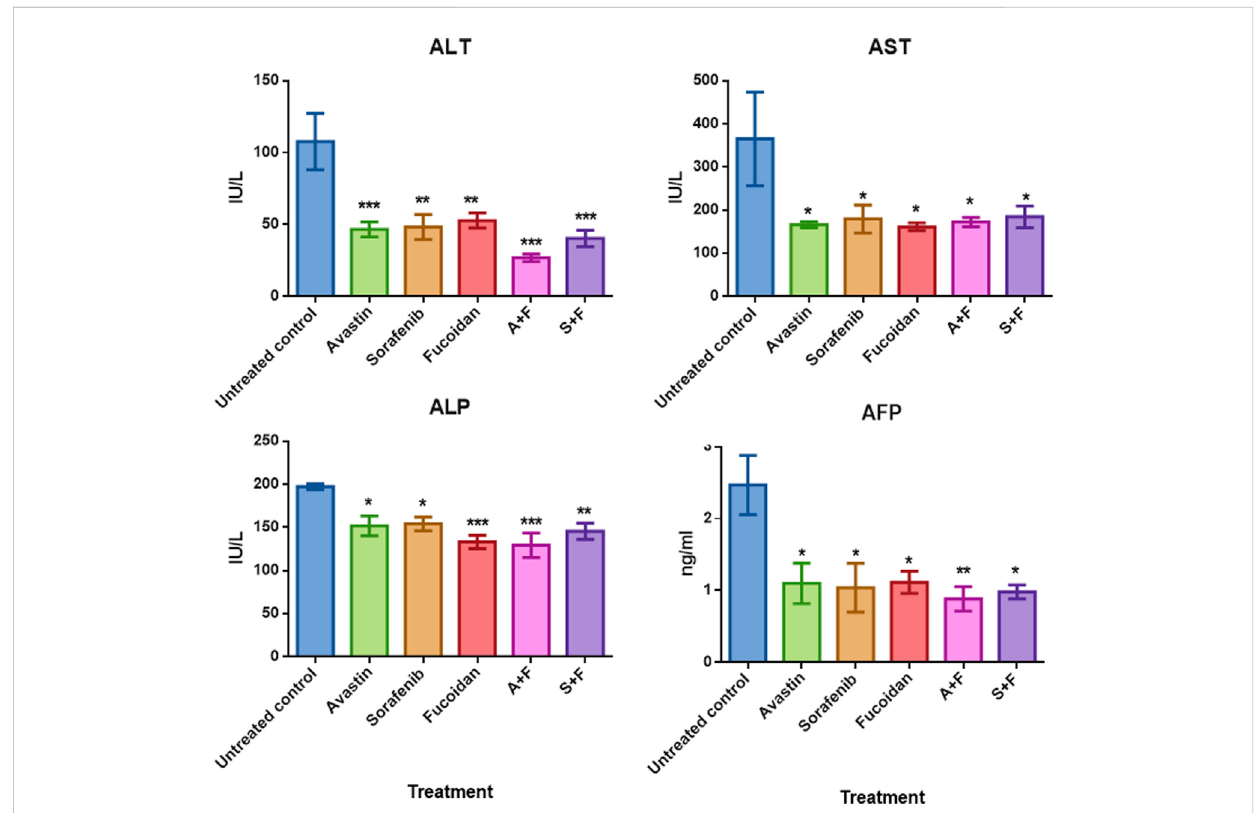
FIGURE 9 The effect of the different treatments on the levels of serum transaminases, ALP and AFP in DEN-HCC rat models. All drug treatments signi fi cantly reducedthelevelsofALT,AST,ALPandAFPwithnosigni fi cantdifferencedetectedamongstthetreatmentgroups.n=3 – 5/group,* p < 0.05,** p <